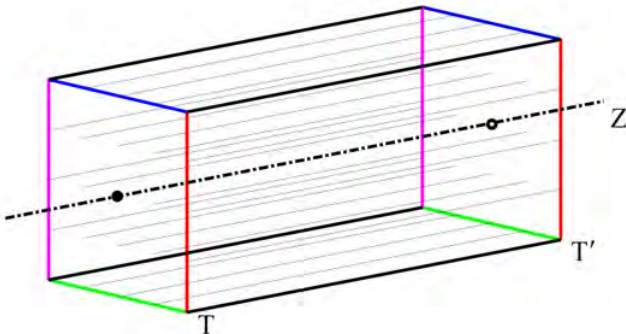
Figure 1 Pencil of null divergency at entrance plane T, that is, OM = D. The divergency is also null at the exit plane T ′ and everywhere else. Z is the longitudinal axis. Twenty-five rays are shown entering at T in a 5-by-5 square array. Azimuth °− 43 43, elevation 12 °− 43